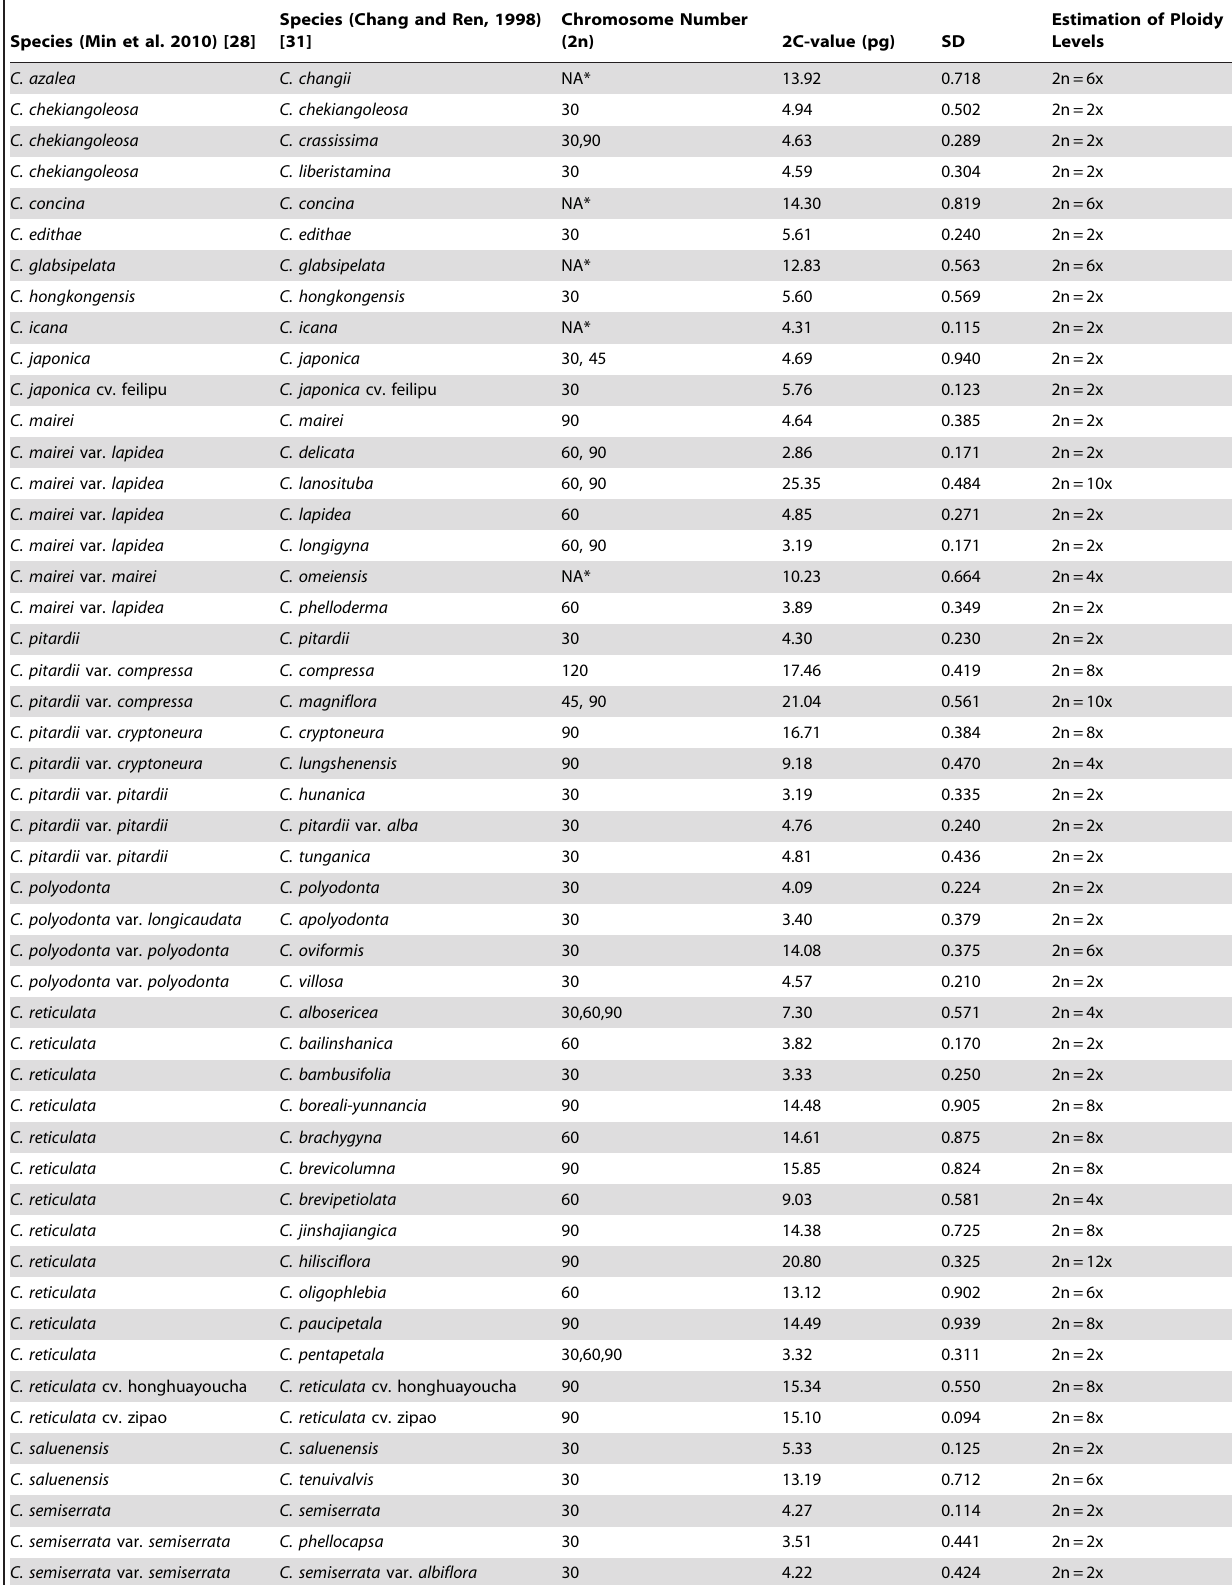
Table 4. Nuclear DNA amount of the section Camellia species estimated with flow cytometry.